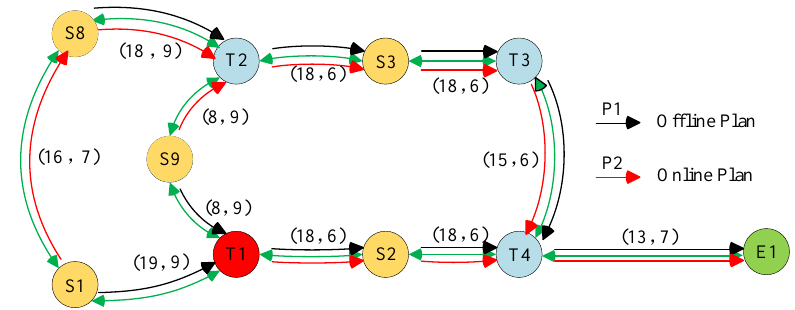
Figure 9. The results of dynamically optimizing the